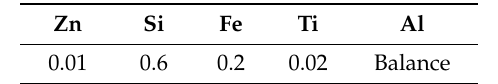
Table 1. Chemical compositions of commercial purity AA1100 Al sheets (wt %).